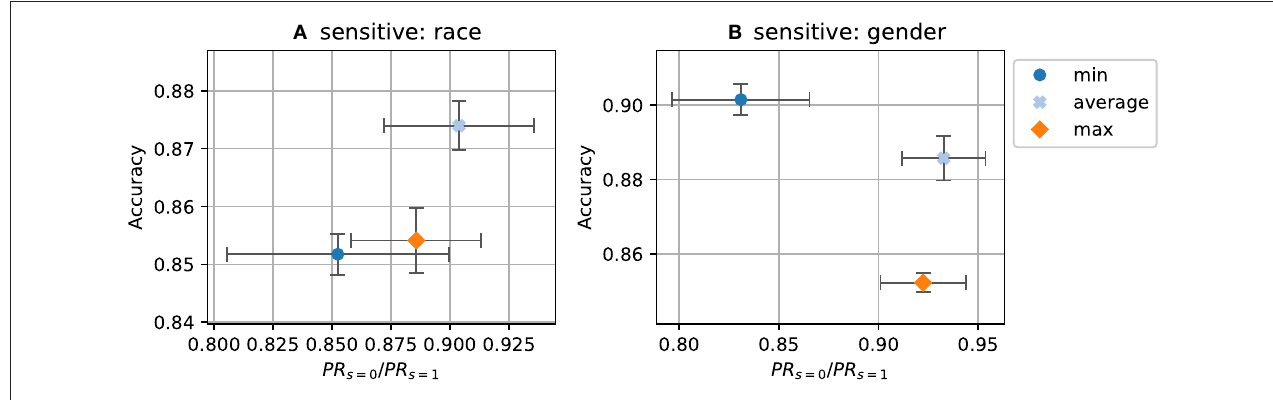
FIGURE 1 | Accuracy and fairness (demographic parity) for various target choices. (A) Adult dataset using race as the sensitive attribute; (B) Adult dataset using gender. Center of the cross is the mean; height and width of the box encode half of standard derivation of accuracy and disparate impact.